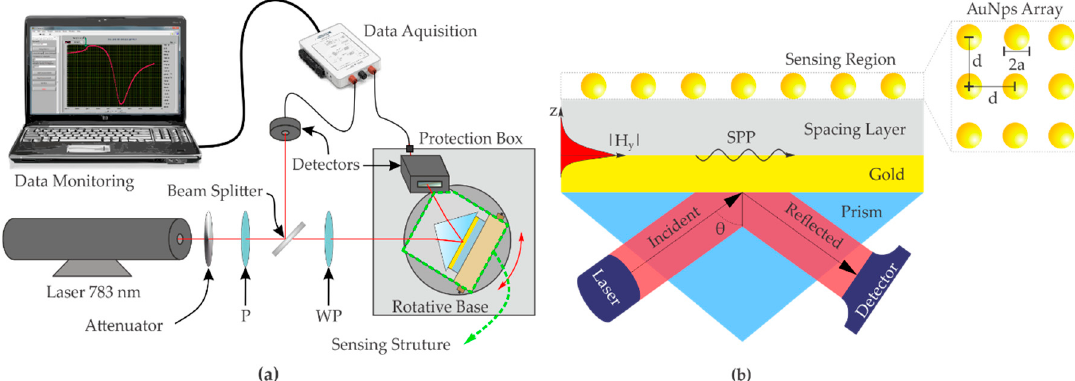
Figure 1. ( a ) Illustration of the experimental SPR set-up in Kreschtmann configuration. P: linear polarizer. WP: λ /4 wave-plate. ( b ) The sensing structure is composed of a coupling prism, a thin film of gold (~ 50 nm) and a dielectric spacer layer (SiO 2 ).